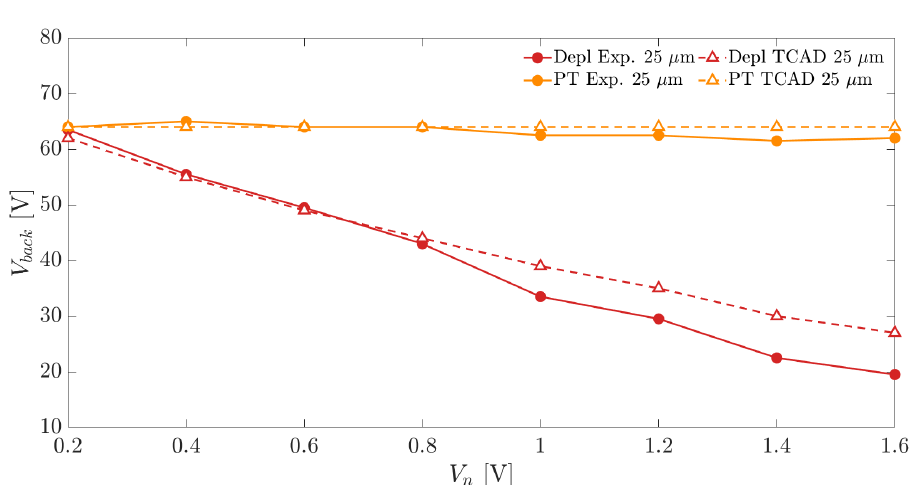
Figure 15. Depletion and punch-through voltages as a function of the applied frontside bias V n for a substrate thickness of 100 µ m.